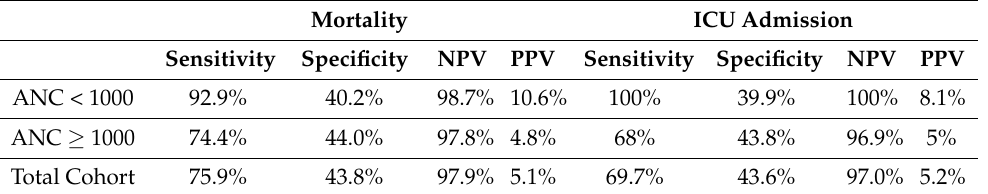
Table 3. Procalcitonin test characteristics for mortality and ICU